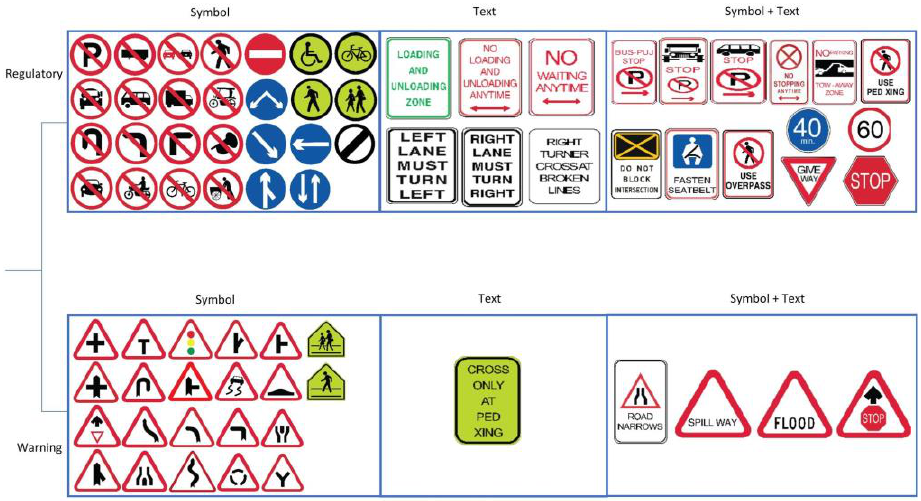
Figure 3. Traffic signs classification based on traffic sign type and display condition.